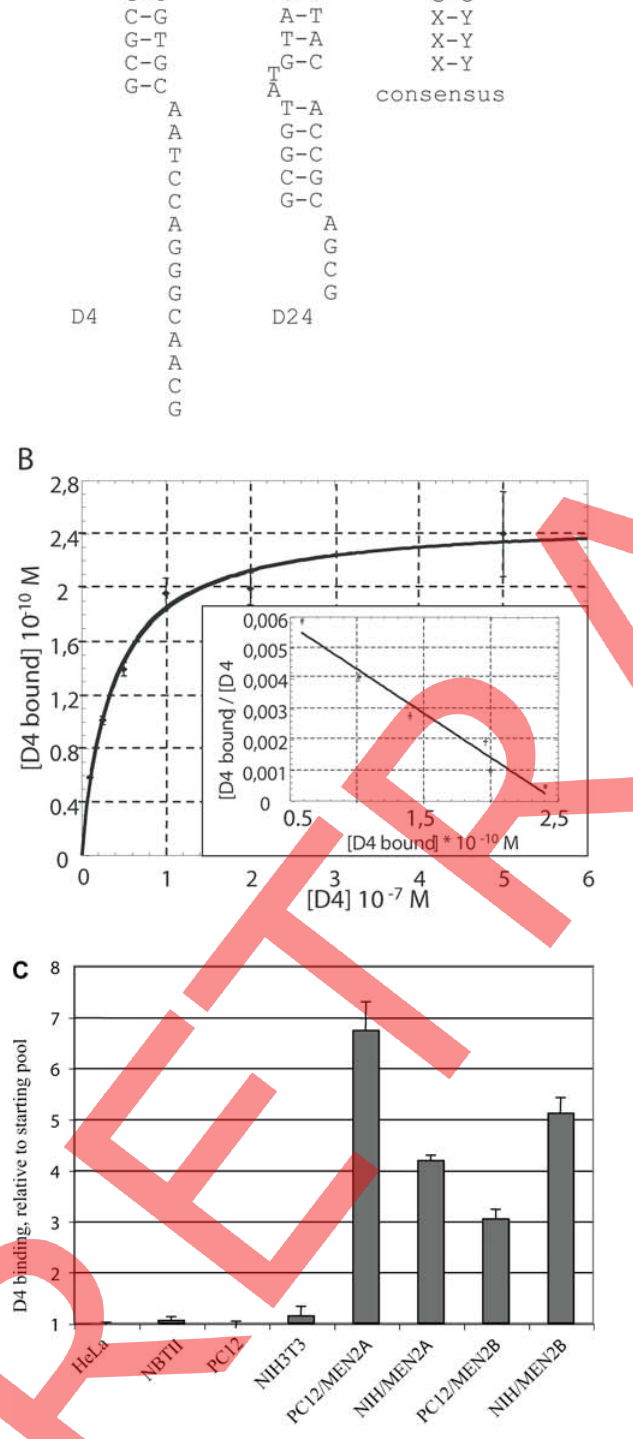
Figure 2. Predicted Structure and Association Constants of D4 and D24 (A) Comparison of a secondary structure prediction for the D4 and D24 aptamers . Structures were predicted using MFOLD software ver- sion 3.1 (available at http://www.bioinfo.rpi.edu/applications/mfold/). (B) Binding curve of the D4 aptamer on PC12/MEN2A. D4 was 32 P-radiolabeled and incubated at different concentrations on cell monolayers. The background binding value for a D4 scrambled sequence is subtracted from every data point. Scatchard analysis (inset) was used for the evaluation of the binding constant. (C) Binding of the 32 P-labeled D4 aptamer to several cell lines expressing (or not) human RET. Binding was performed on the cell lines indicated in the same condition at 50 nM, and the results are expressed relative to the background binding detected with the starting pool of sequences used for selection. Expression of RET could not be detected by Western blot in HeLa, NBTII, PC12wt and NIH3T3 cells, whereas PC12/MEN2A and NIH3T3/MEN2A express RET C634Y and PC12/MEN2B and NIH3T3/MEN2B express RET M918T . DOI: